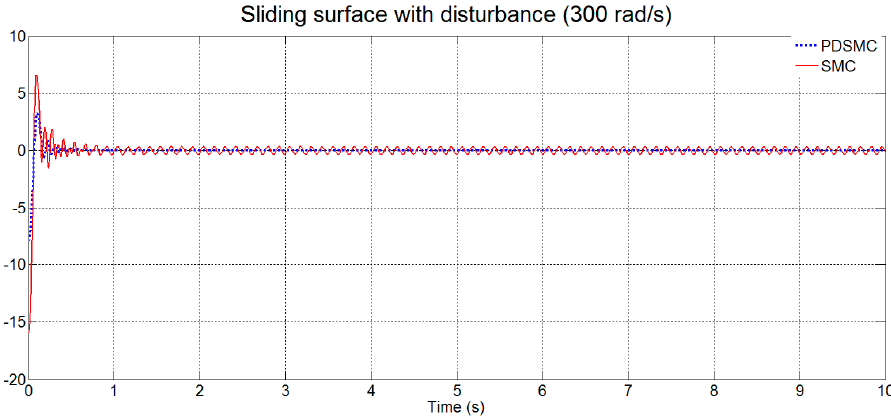
Figure 10. Effect of disturbance on sliding surface.